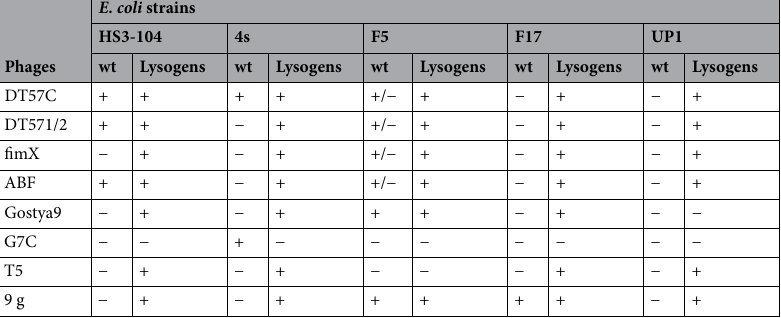
Table 1. Sensitivity of the E. coli strains and their derivative